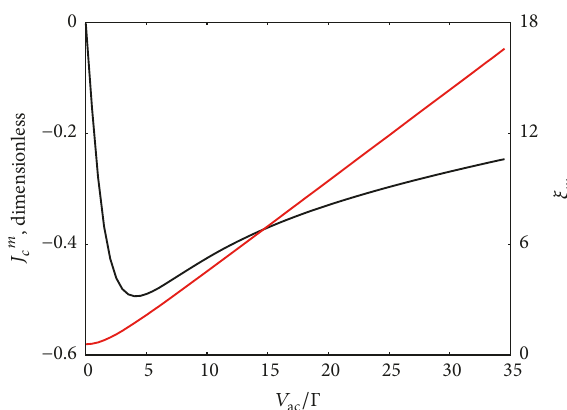
Figure 4: Operating point position relative to the maximum NDC as a function of the Fermi energy for RTD heterostructure number 1 at the following frequencies and temperatures: ℎ𝜔 = 4Γ , 𝑇 = 300 K (green line); ℎ𝜔 = 4Γ , 𝑇 = 0 K (purple line); ℎ𝜔 = 8Γ , 𝑇 = 300 K (orange line); ℎ𝜔 = 8Γ , 𝑇 = 0 K (blue line); ℎ𝜔 = 14Γ , 𝑇 = 300 K (black line); ℎ𝜔 = 14Γ , 𝑇 = 300 K (red line).